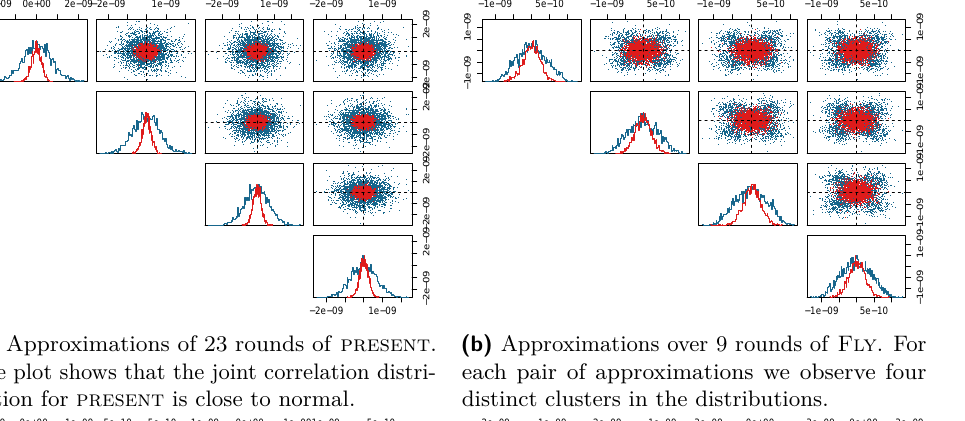
−1e−09 0e+00 1e−09